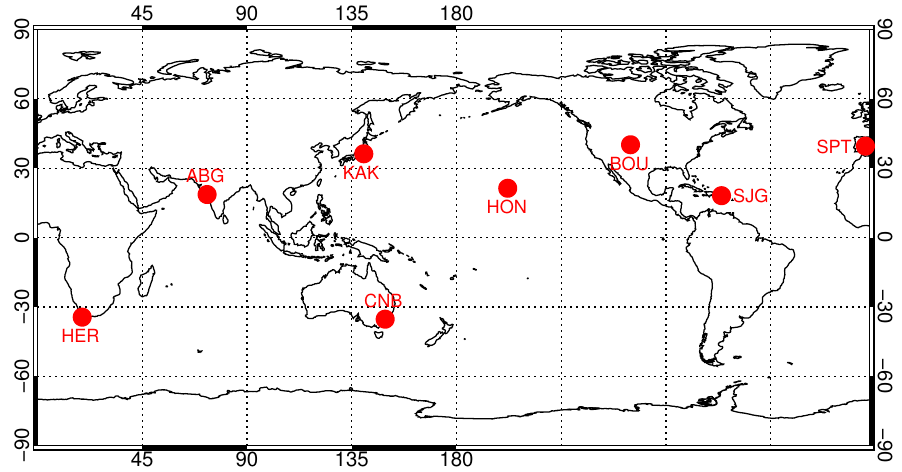
Figure 3. The global map with these eight stations locations marked as red